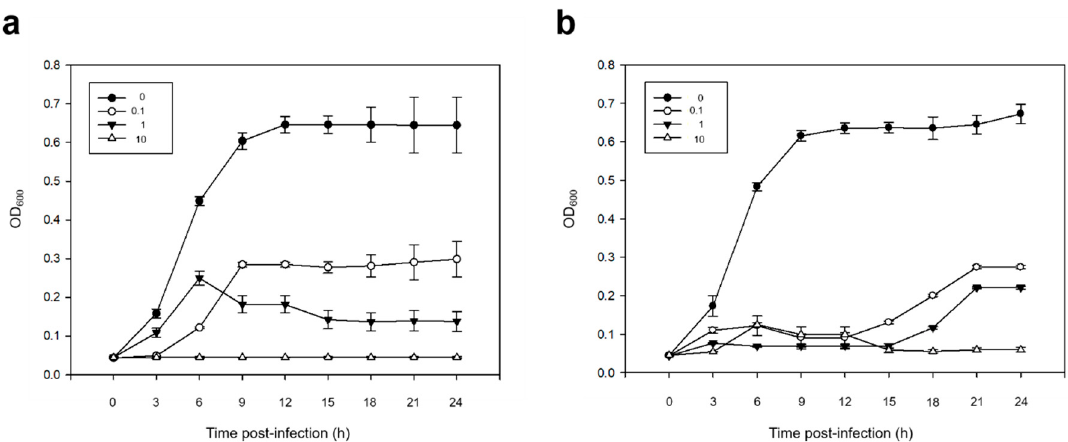
Figure 3. Cell lysis effect of pVco-5 ( a ) and pVco-7 ( b ) against V. coralliilyticus 58 in various multiplicities of infections (MOIs). As a result of statistical analysis, the p value for each hour was verified to be less than 0.001 when both pVco-5 and pVco-7 were compared to the control group (MOI: 0).